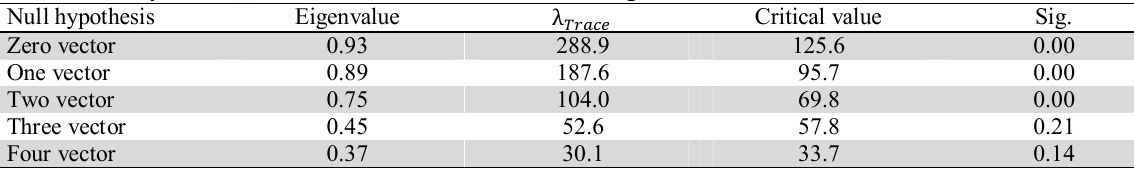
for minimum number of co-integration The summary of λ  Null hypothesis Eigenvalue λ Zero vector